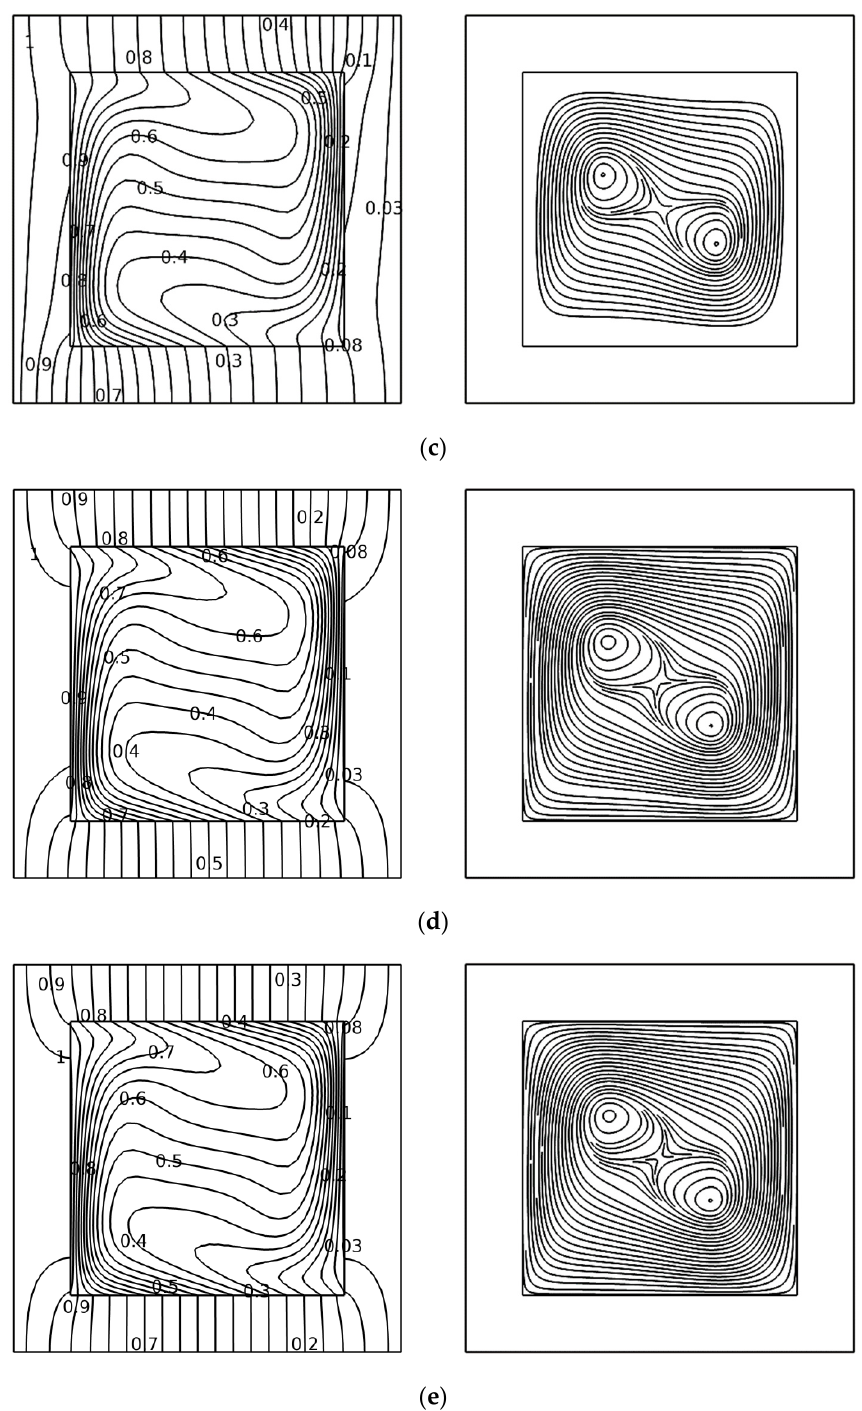
Figure 5. Streamlines and isothermals obtained for ( a ) Kr = 0.1, W max = 19.782, ( b ) Kr = 1, W max = 46.635, ( c ) Kr = 10, W max = 80.813, ( d ) Kr = 100, W max = 92.874 and ( e ) Kr = 1000, W max = 94.664.